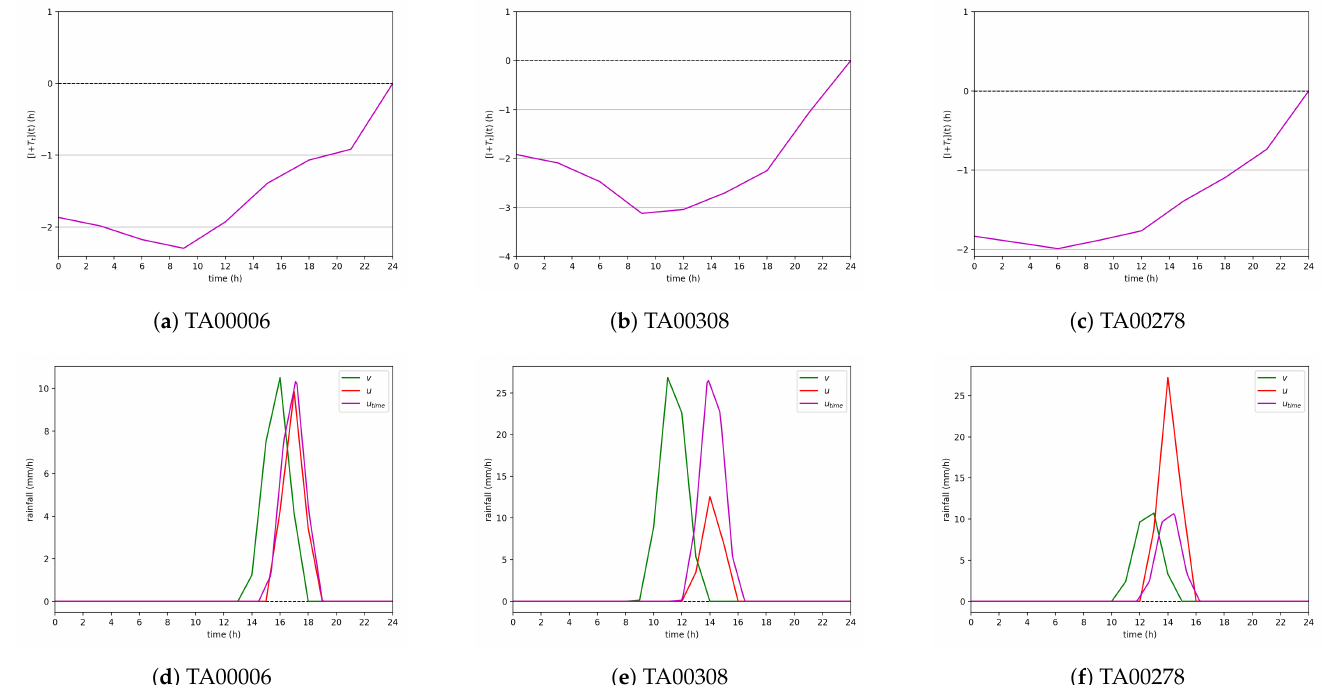
Figure 7. Mappings T t ( a – c ) and corresponding warped signals ( d – f ) at three stations: ( a , d ) TA00006, ( b , e ) TA00308, and ( c , f ) TA00278.